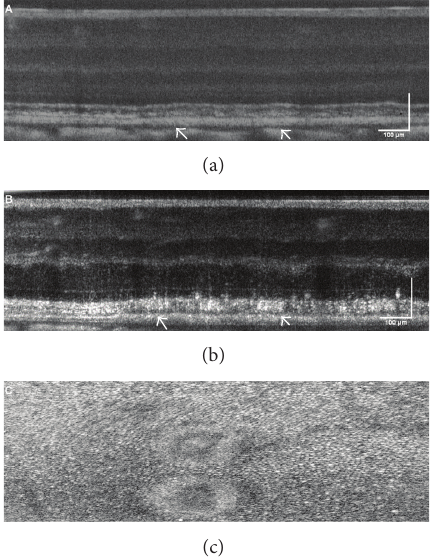
Figure 4: OCT B-scans of a multiple pulse exposure, (1,317mJ/cm 2 ) totheretinaofsubjectS2ODcollectedat(a)1hourand(b)24hours. (c) is an en face view of the retina photoreceptor layer of subject S3 OD after receiving a multiple pulse exposure, (874 J/cm 2 ). Scale bar: 100 𝜇 m.